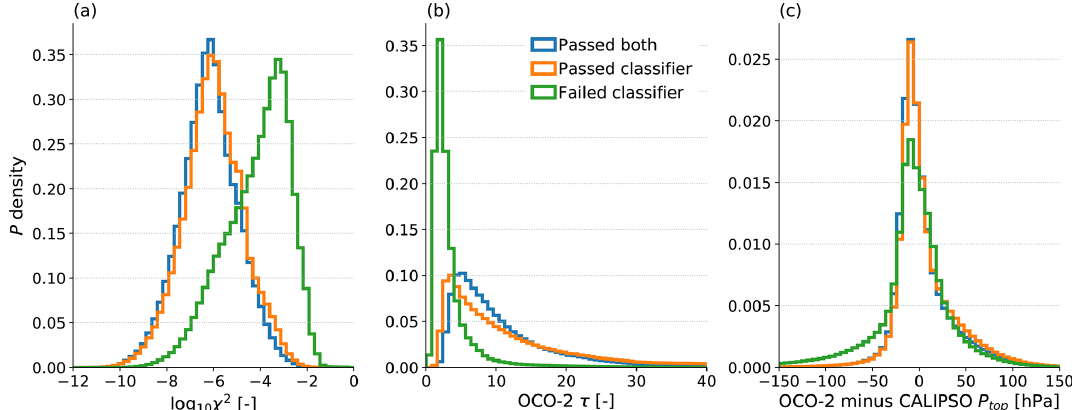
Figure 7. Normalised histograms of OCO2CLD-LIDAR-AUX outputs where SZA < 45 ◦ , separated into whether the soundings pass the new pre-processor flag and retrieval or not. The “passed both” set are those that returned valid cloud properties from the LUT along with T top > 0 ◦ C; the “passed-classifier” case gave invalid cloud values or had T top < 0 ◦ C; and the “failed-classifier” set are those that were attempted in OCO2CLD-LIDAR-AUX but are not passed by the new classifier. (a) Logarithm of χ 2 ; (b) retrieved τ ; (c) P top minus the closest CALIPSO retrieved P top